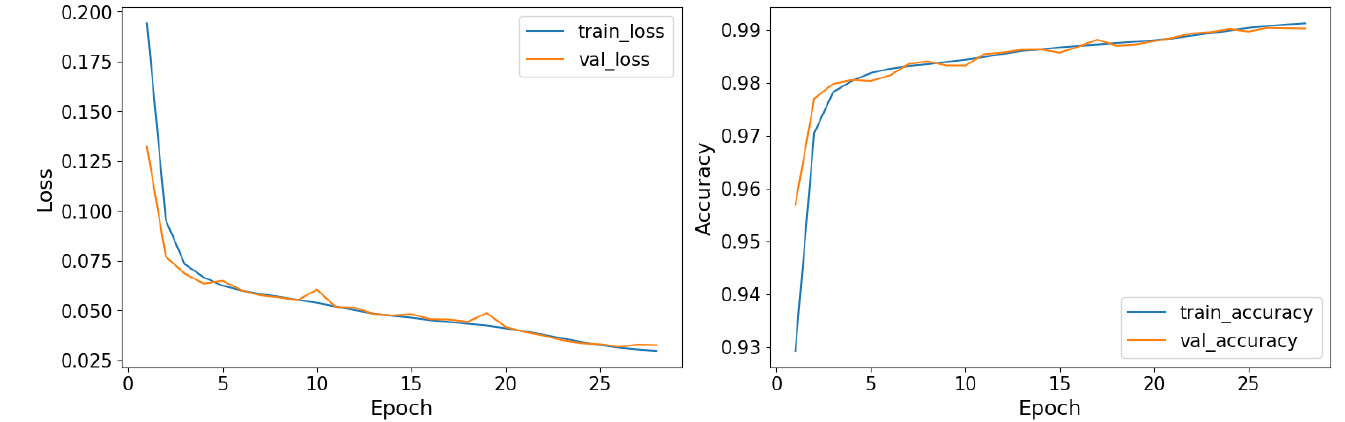
Figure 8. Training history of the CNN model. In the left panel, the loss function against the epochs for the training (blue) and validation (orange). In the right panel, the accuracy as a function of the epochs for the training (blue) and validation (orange).